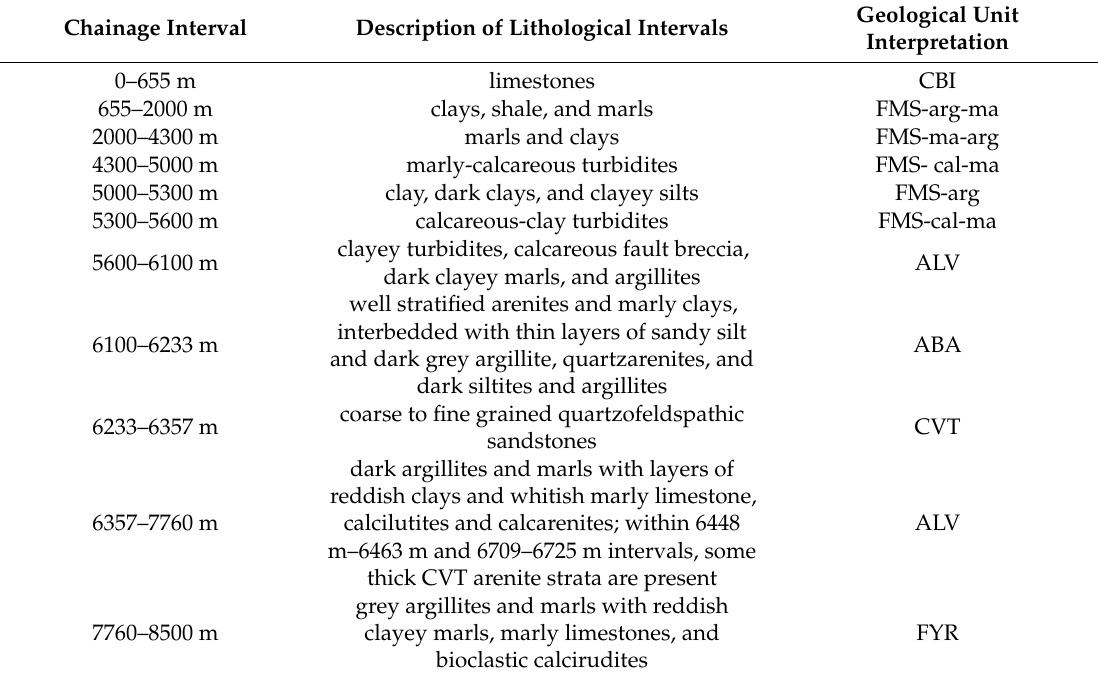
Figure 6. Fault plane dislocating the stratigraphic sequence. Table 1. Lithological units crossed by the Pavoncelli bis tunnel. Geological unit codes: ALV, Argille Varicolori Superiori Fm.; ABA, Albanella / Corleto unit; CBI, bio-litoclastic rudist limestone fm.; FYR, Flysch Rosso Fm.; CVT, Castelvetere Formation; FMS, Monte S. Arcangelo Fm. with four lithofacies: FMS-arg (argillaceous lithofacies), FMS-arg-ma (argillaceous-marly lithofacies), argillaceous lithofacies), and FMS-cal-ma (calcareous-marly lithofacies).